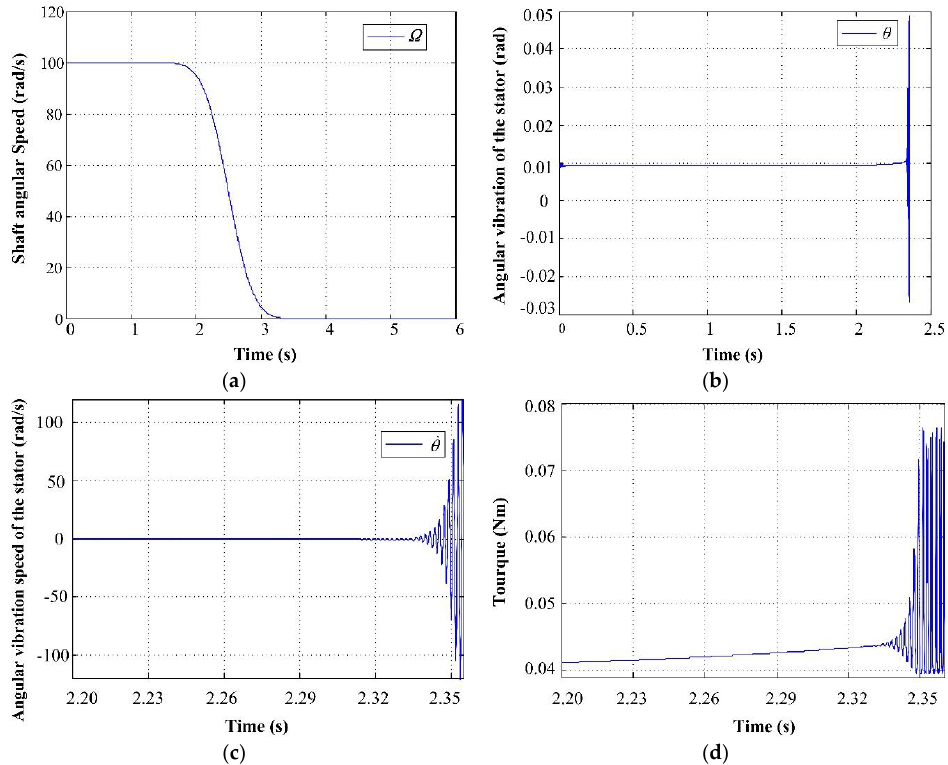
Figure 6. ( a ) Shaft deceleration curve; ( b ) angular vibration of the stator; ( c ) angular vibration speed of the stator; ( d ) total torque. the stator; ( d ) total